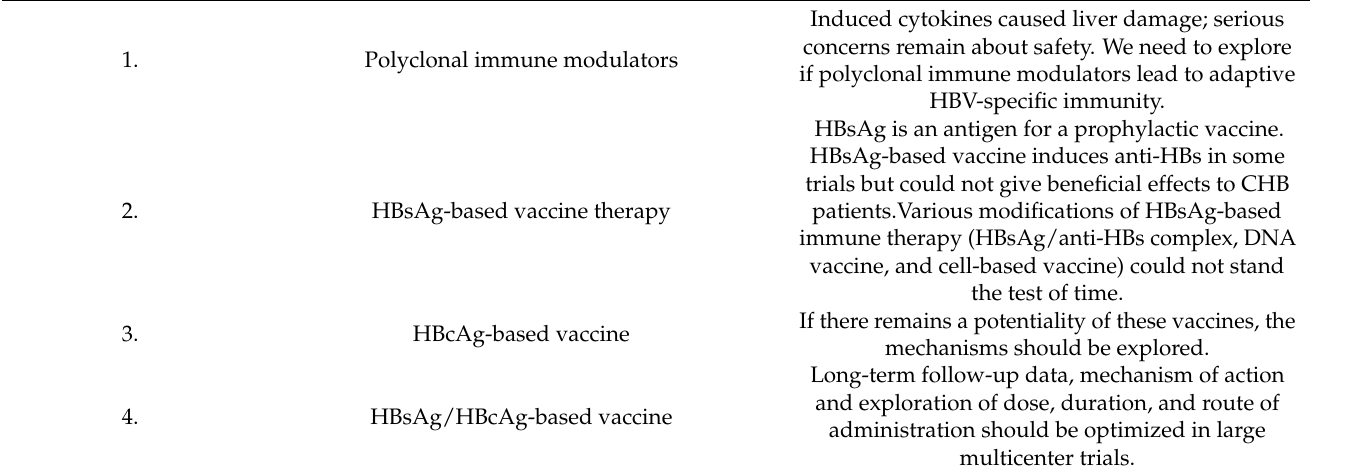
Table 4. Visible limitation of innovative immune